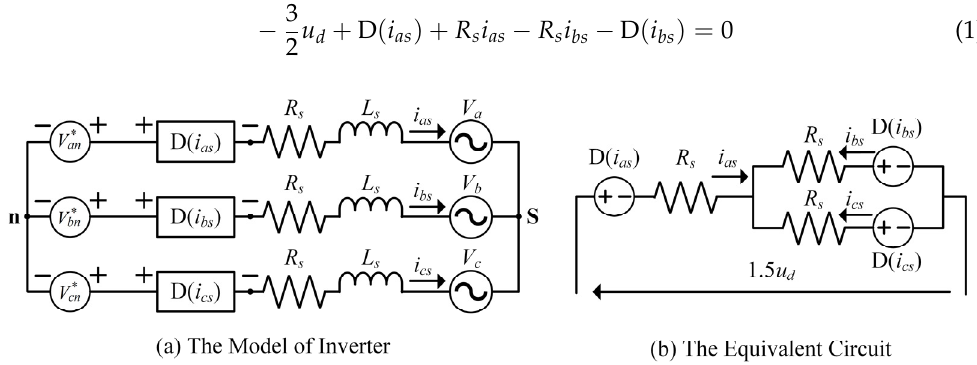
Figure 3. The offline identification equivalent circuit